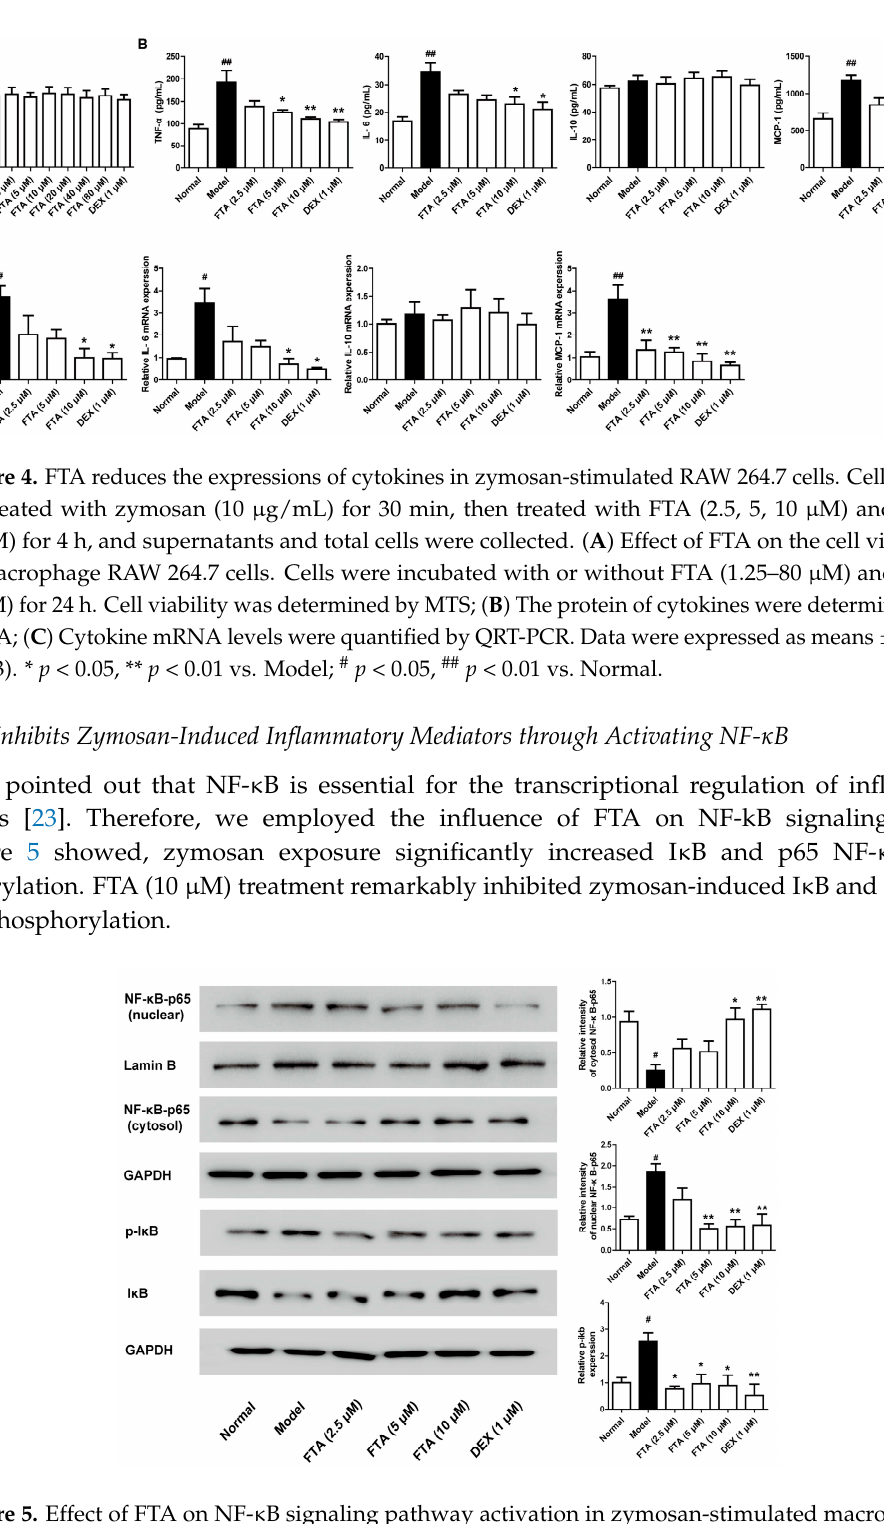
Figure 5. Effect of FTA on NF- κ B signaling pathway activation in zymosan-stimulated macrophage RAW 264.7 cells. Cells were treated with FTA or DEX in the presence or absence of zymosan (10 μ g/mL). NF- κ B-p65 and I κ B expression were detected by Western blotting. Data were expressed as means ± SEM ( n = 3). * p < 0.05, ** p < 0.01 vs. Model; # p < 0.05 vs. Normal.